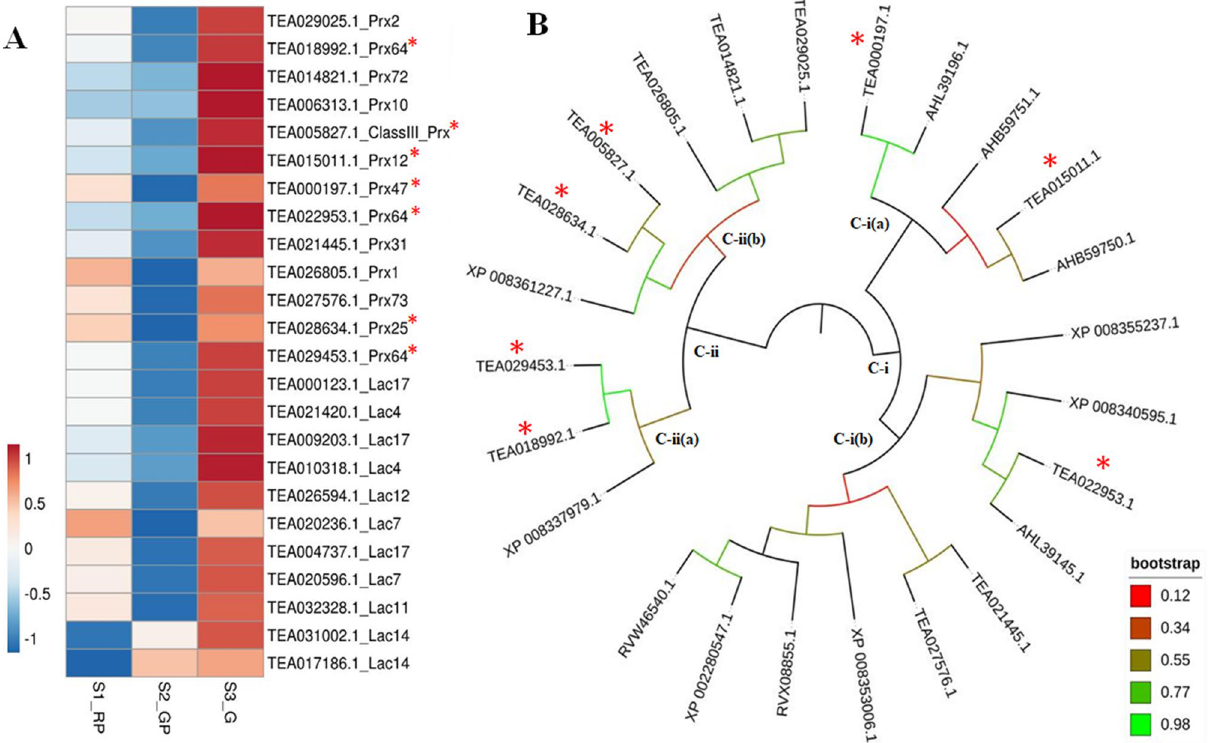
Figure 7. ( A ) The expression pattern of DE candidate peroxidases and laccases. ( B ) Phylogenetic tree of DE putative peroxidases and functionally characterized peroxidases. The * indicates tea peroxidases exhibiting significant homology with known